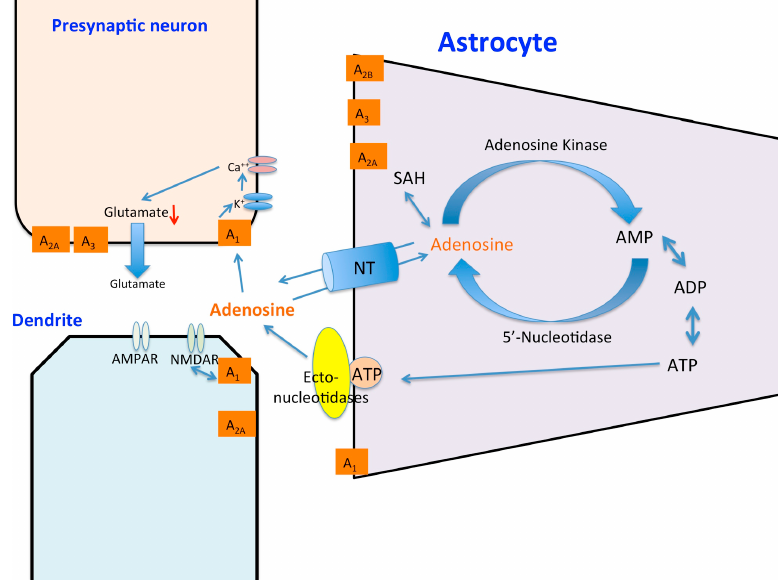
Figure 1. The effects of hypoxia on adenosine release in the CNS. Hypoxia causes a breakdown of extracellular ATP and AMP along with activation of membrane-bound transporters such as